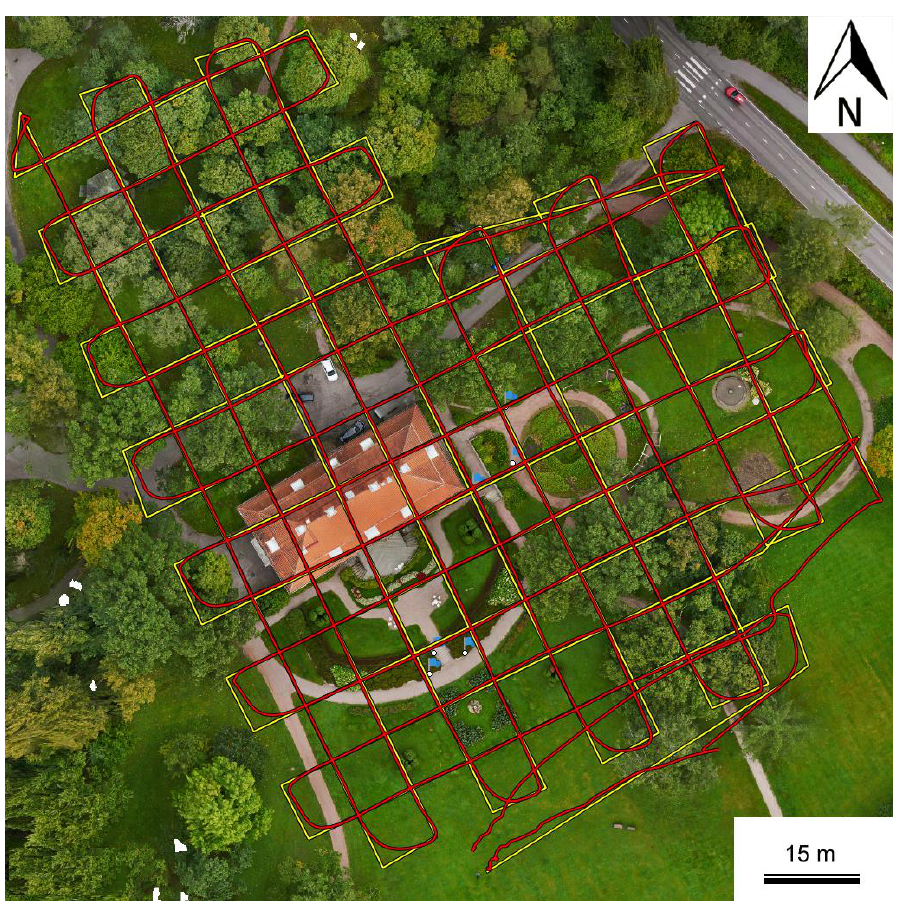
Figure 1. Tarot T960 survey mission. Flight plan is illustrated in yellow, and the actual flight path in red.